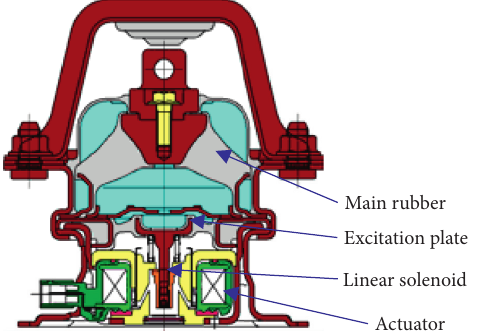
Figure 4: AEM working with a solenoid [61,